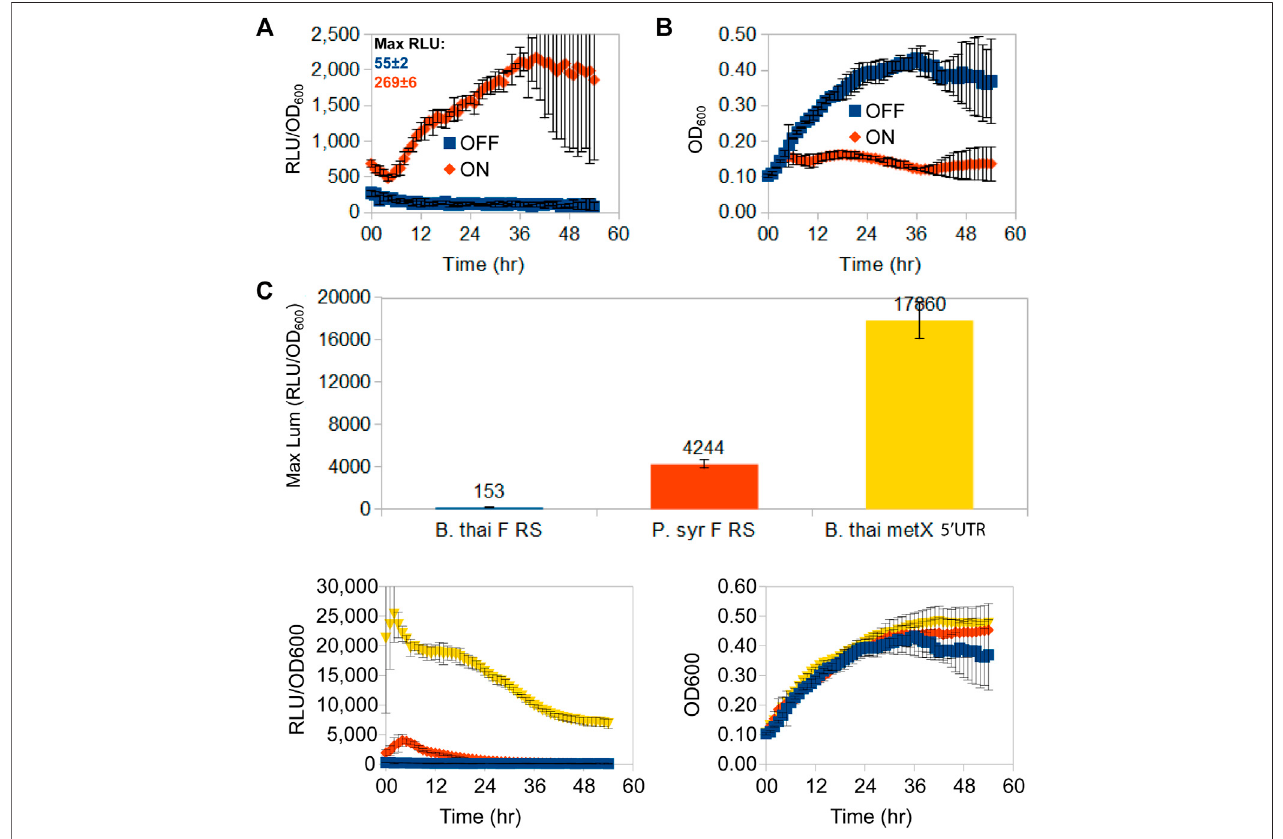
FIGURE2| Time-courseluminescenceinductioncurvesof B.thailandensis E264clonescontainingthe B.thailandensis fl uorideriboswitchandrepressioneffect.A 54 h time-course lux expression assay comparing lux /OD (A) and growth curves (B) of B. thailandensis E264 containing the P1- B. thai F RS- lux (pVK-f2- lux ) construct s (See Supplementary Table S3 : B. thailandensis E264/ P1 + B. thai F) for either an ON-induced state of the fl uorideriboswitch in the presence of 31 mM F − , or an OFF- repressedstate fl uorideriboswitchintheabsenceofF − .Culturesweregrownandmeasuredonthesame96-wellmicroplateassayrunandmaximumpeaklevelsof luciferase expression are indicated above curves in Relative Luminescence units (RLU) for un-normalised-to-OD signal strength comparison. The data points represent themeansandstandarddeviationsoftriplicatevalues. (C) Invivo repressioncapabilityofthreeOFF-repressedriboswitch-containingconstructsin B.thailandensis E264: B. thailandensis fl uoride riboswitch construct (pVK-f2- lux — B. thai F RS), the P. syringae fl uoride riboswitch (pVK-f- lux — P. syr F RS), and the B. thailandensis metX 5 ′ UTR ( B. thai metX 5 ′ UTR). OFF-repression was achieved with 0 mM F- for fl uoride riboswitch constructs and with 0.05 mM methionine for the metX 5 ′ UTR construct which is suspected to have a regulatory element (Leyn et al., 2014; and unpublished data). RLU per OD 600 and growth curves are shown as well (bottom left and right respectively). The data points represent the means of triplicate